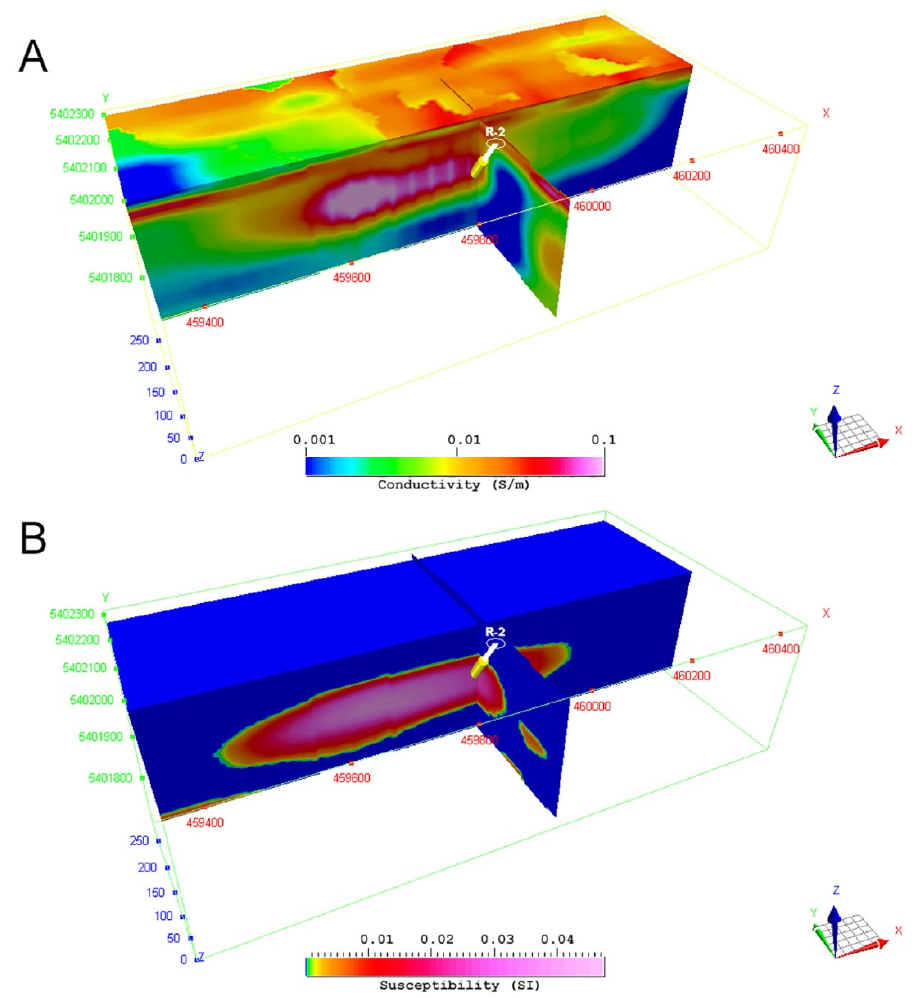
Figure 5. The Reid-Mahaffy test site. Panel ( A ) shows the 3D conductivity (S/m) model produced from joint inversion with Gramian-based structural constraints. Panel ( B ) presents the 3D suscepti- bility (SI) model produced from Gramian joint inversion. The red arrow is easting, and the green arrow is northing. The location of the borehole is shown by short white line. The yellow cylinder on the borehole indicates the confirmed zone of mineralization.